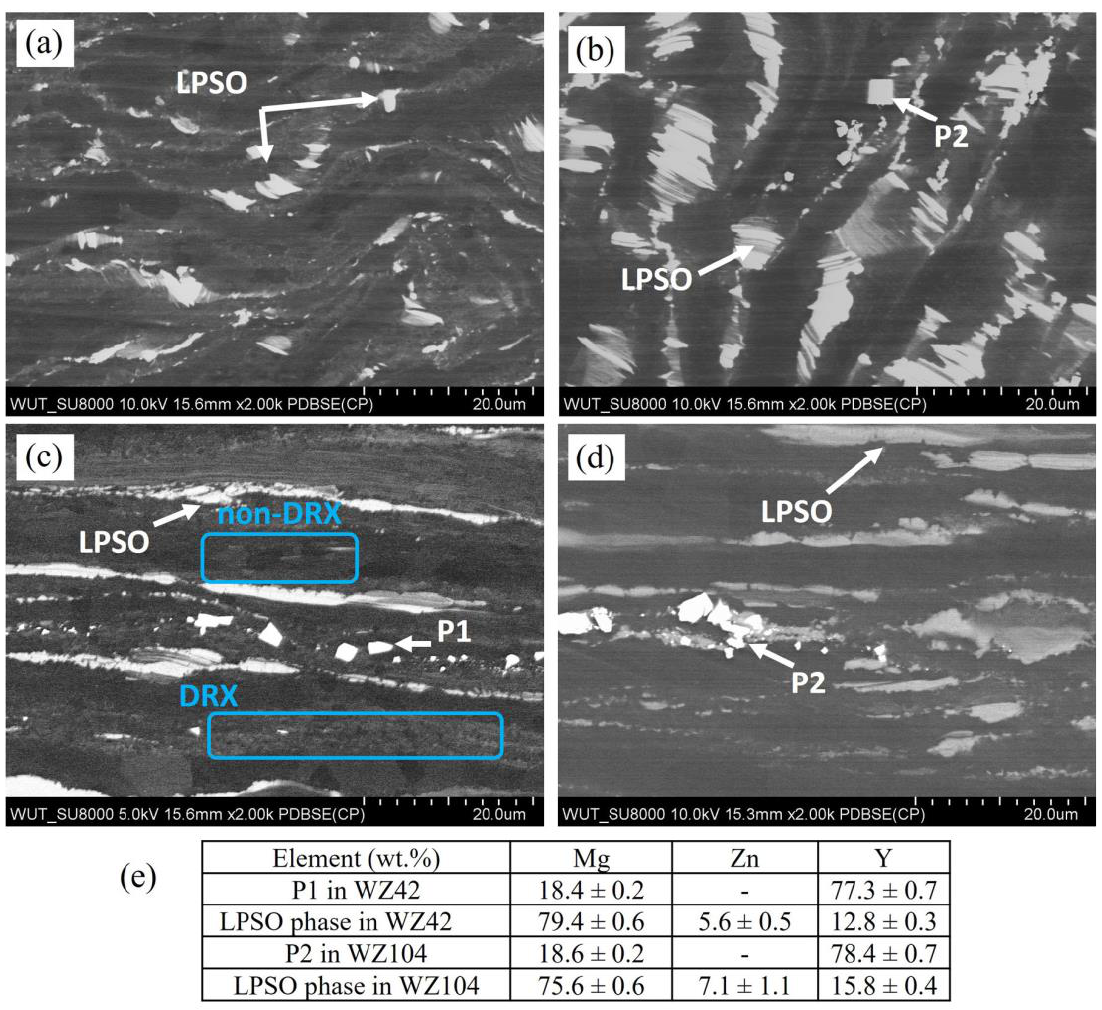
Figure 2. SEM microstructures of WZ42 and WZ104 alloys: ( a ) WZ42—surface perpendicular to the extrusion direction, ( b ) WZ104—surface perpendicular to the extrusion direction, ( c ) WZ42—surface parallel to the extrusion direction, ( d ) WZ104—surface parallel to the extrusion direction, ( e ) EDX analyses of the precipitations marked as P1 and P2, and EDX of LPSO structures formed in WZ42 and WZ104.